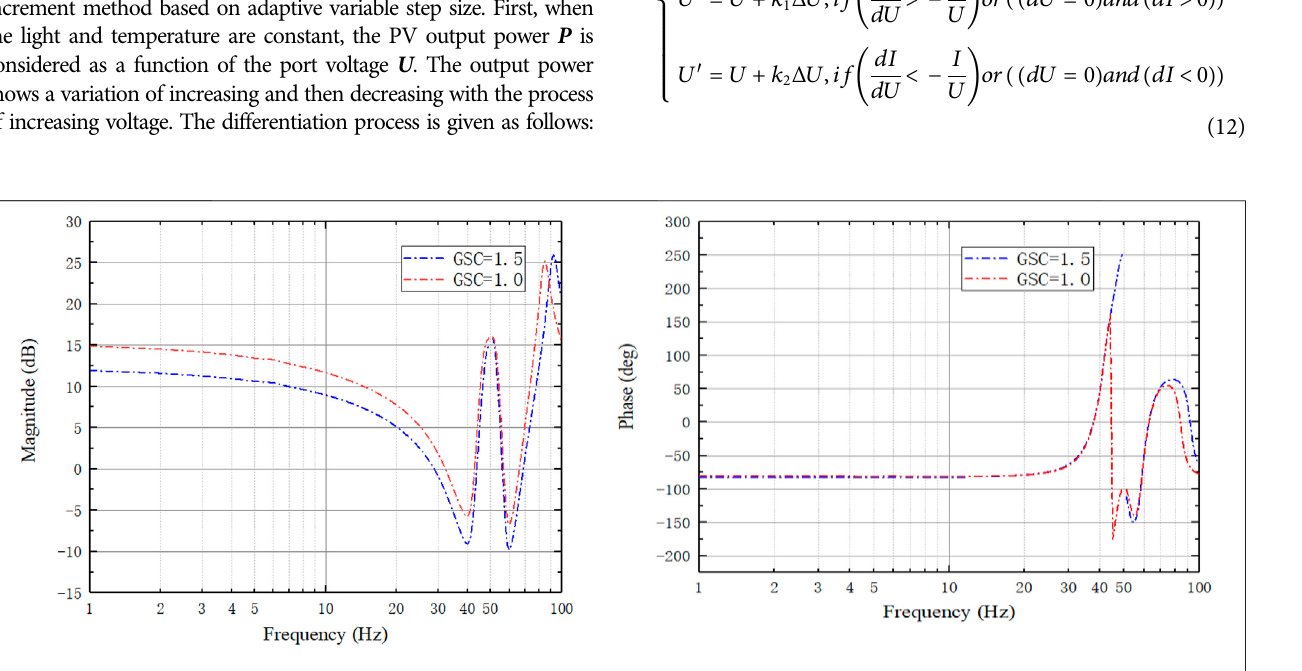
FIGURE 7 | Frequency response of the grid impedance.